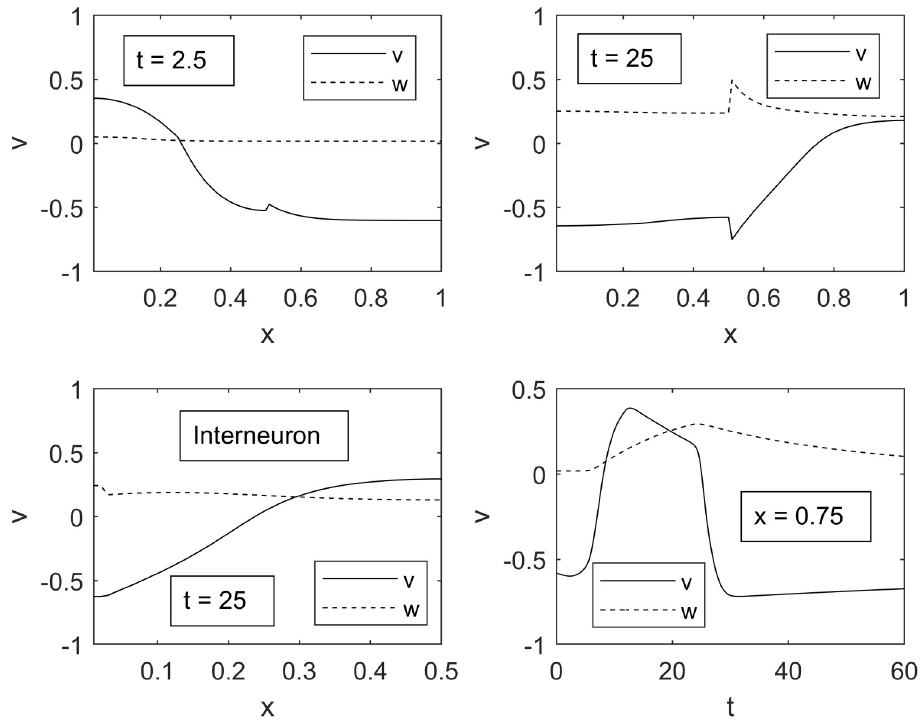
Fig 5. Transmembrane potential v and gating variable w as functions of spatial variable x . Upper panels show a spatial evolution of the excitation pulse in the sensory and motor neurons in the interval of time between 2.5 and 25. Lower left panel shows progression of the excitation pulse in the interneuron at time 25. Lower right panel illustrates temporal evolution of excitation at x = 0.75. Parameters C 1 , C 2 , and C 3 are equal to 1, 1.8, and -0.2, respectively, for ideal propagation through all